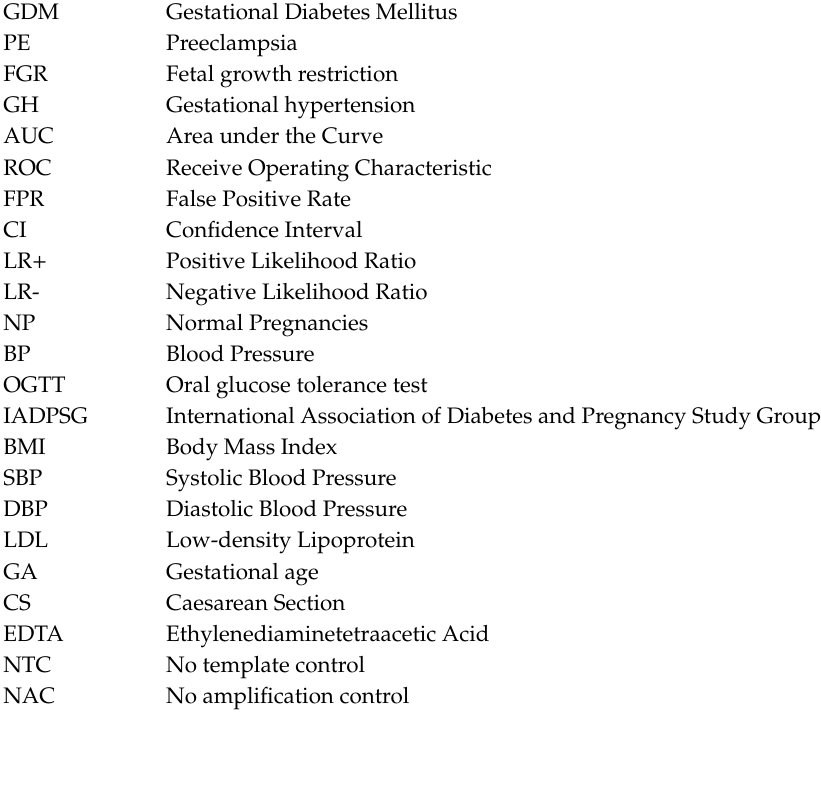
Table S7: A list of predicted targets of appropriate microRNAs dysregulated in whole peripheral blood of children descending from GDM complicated pregnancies in relation to heart valve disease using miRWalk2.0 database (putative microRNA binding sites predicted by miRWalk algorithm within mRNA selected regions); Table S8: A list of predicted targets of appropriate microRNAs dysregulated in whole peripheral blood of children descending from GDM complicated pregnancies in relation to heart disease using miRWalk2.0 database (putative microRNA binding sites predicted by miRWalk algorithm within mRNA selected regions); Table S9: A list of predicted targets of appropriate microRNAs dysregulated in whole peripheral blood of children descending from GDM complicated pregnancies in relation to heart failure using miRWalk2.0 database (putative microRNA binding sites predicted by miRWalk algorithm within mRNA selected regions); Table S10: A list of predicted targets of appropriate microRNAs dysregulated in whole peripheral blood of children descending from GDM complicated pregnancies in relation to venous insu ffi ciency using miRWalk2.0 database (putative microRNA binding sites predicted by miRWalk algorithm within mRNA selected regions); Table S11: A list of predicted targets of appropriate microRNAs dysregulated in whole peripheral blood of children descending from GDM complicated pregnancies in relation to pulmonary embolism using miRWalk2.0 database (putative microRNA binding sites predicted by miRWalk algorithm within mRNA selected